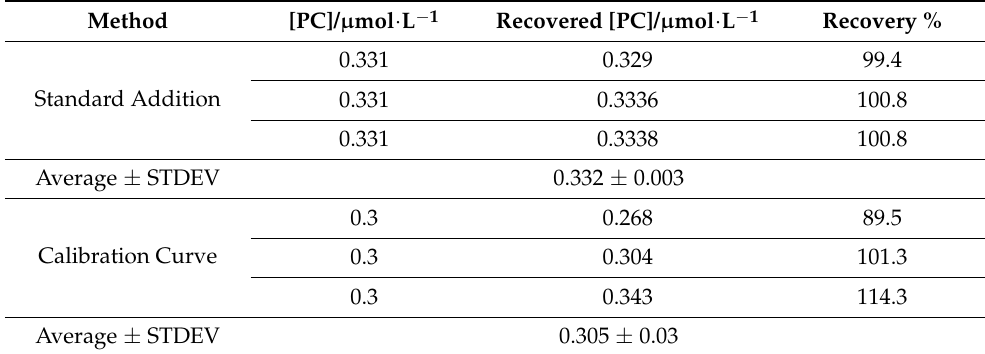
Table 4. Recovery of PC in 500 mg commercial tablet using standard addition method and the use of calibration curve method from peak current response of